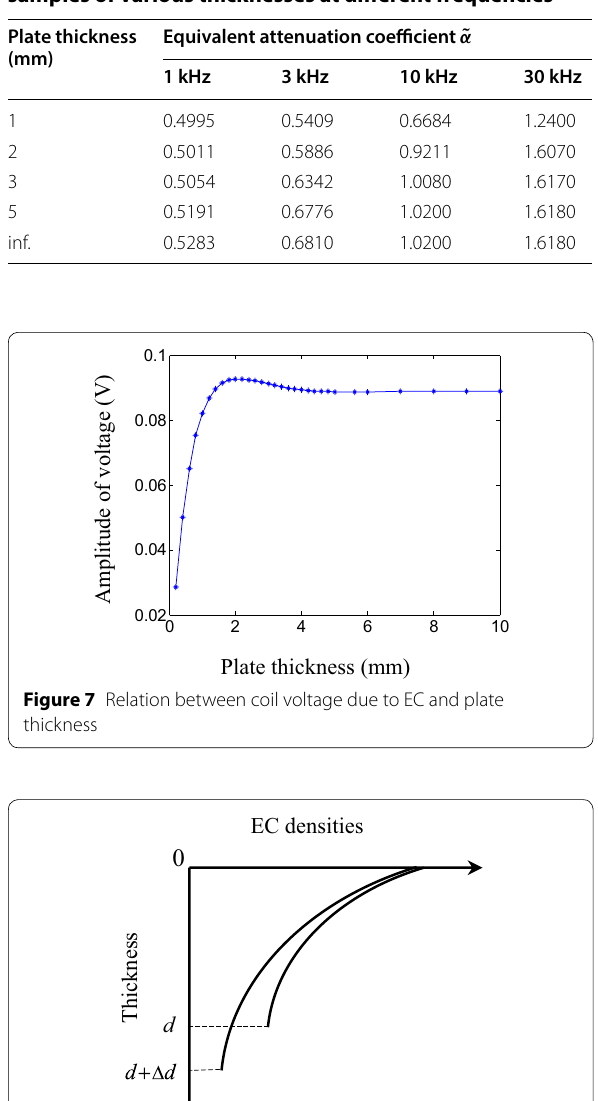
Table 1 Equivalent attenuation coefficient of EC in the test samples of various thicknesses at different frequencies